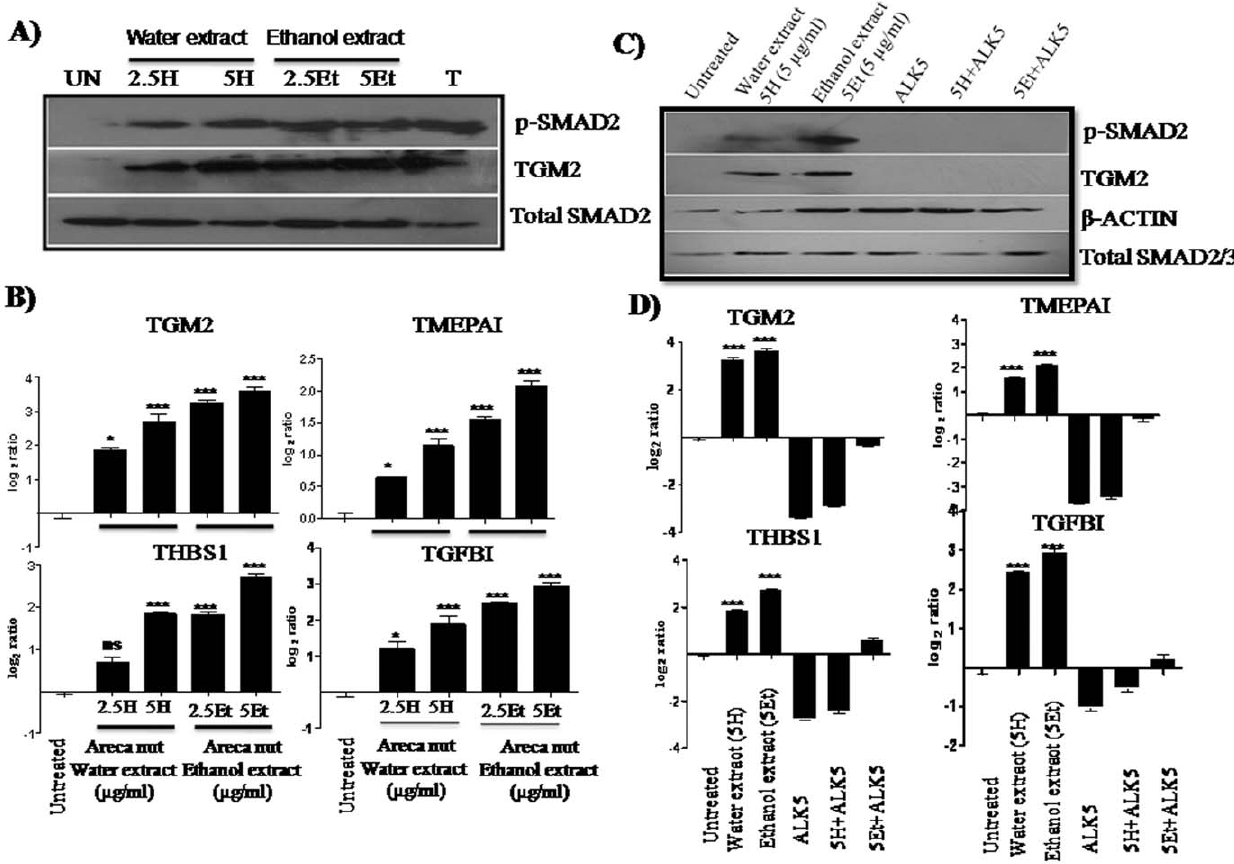
Figure 2. Areca nut induces TGF- b signaling in epithelial cells. A & B] Areca nut induced genes by Western blot and by qRT-PCR. HaCaT cells were serum starved for 24 hours and treated with either areca nut water (H) or ethanol (Et) extracts 2.5, 5 m g/ml (2.5H/5H & 2.5Et/5Et) in serum free medium for 48 hours. A) Western blot of HaCaT cell lysates showing induction of p-SMAD2 and its downstream target TGM2. B) qRT-PCR analysis showing expression of TGF- b down-stream target genes TGM2, TMEPAI, THBS1 and TGFBI. UN -Untreated, 2.5H & 5H 2 2.5 and 5 m g/ml Areca